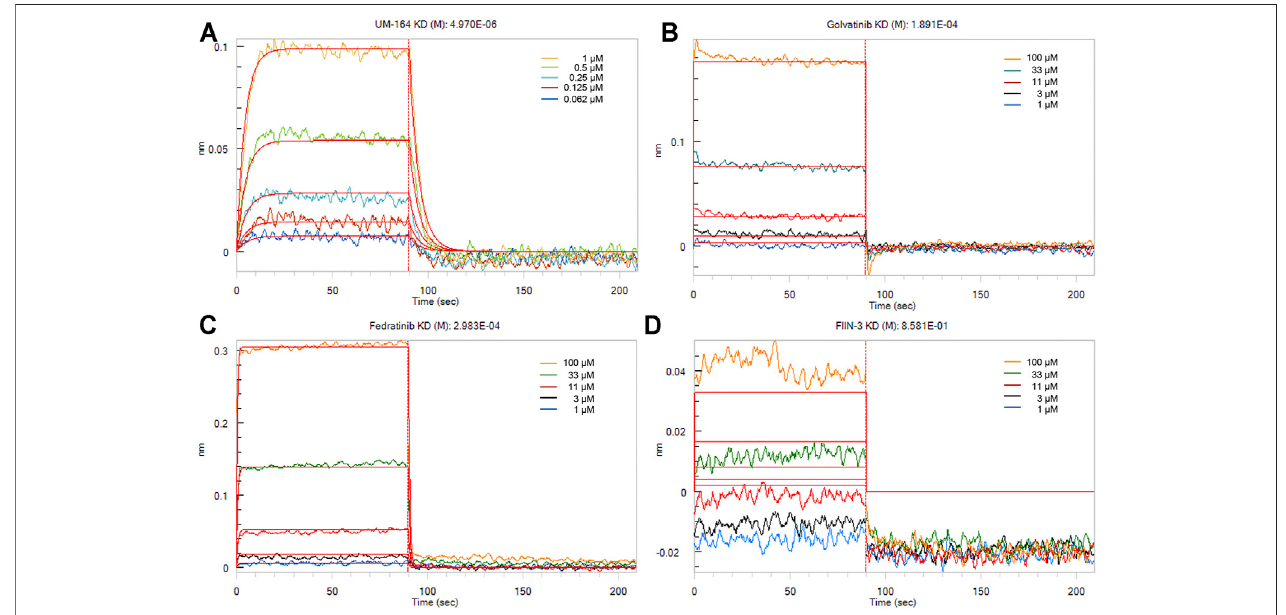
FIGURE 7 | The binding af fi nities of small molecules with TIPE2. TIPE2 proteins were loaded onto SSA biosensors for BLI analysis and incubated with gradient concentrations of UM-164 (A) , Golvatinib (B) , Fedratinib (C) , and FIIN-3 (D) , respectively. The raw binding curves at different concentrations are shown in fi ve kinds of color, and red curves are the best global fi ts to the data used to calculate the K D values.